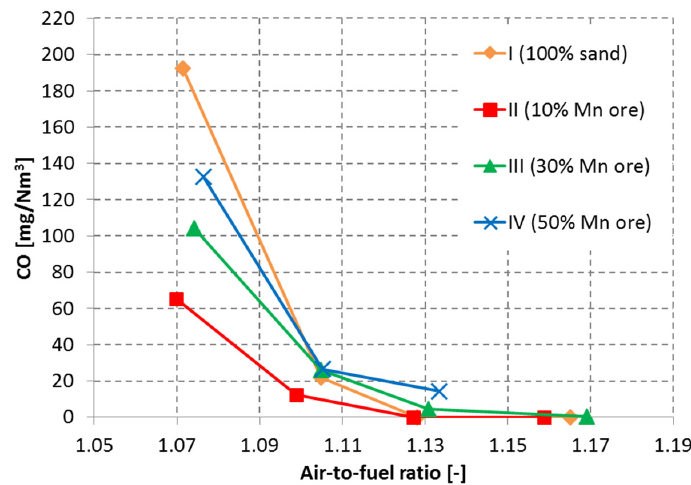
Figure 5. Measured concentrations of CO (mg/nm 3 , at 6% O 2 ) at position kh2 in the convection path